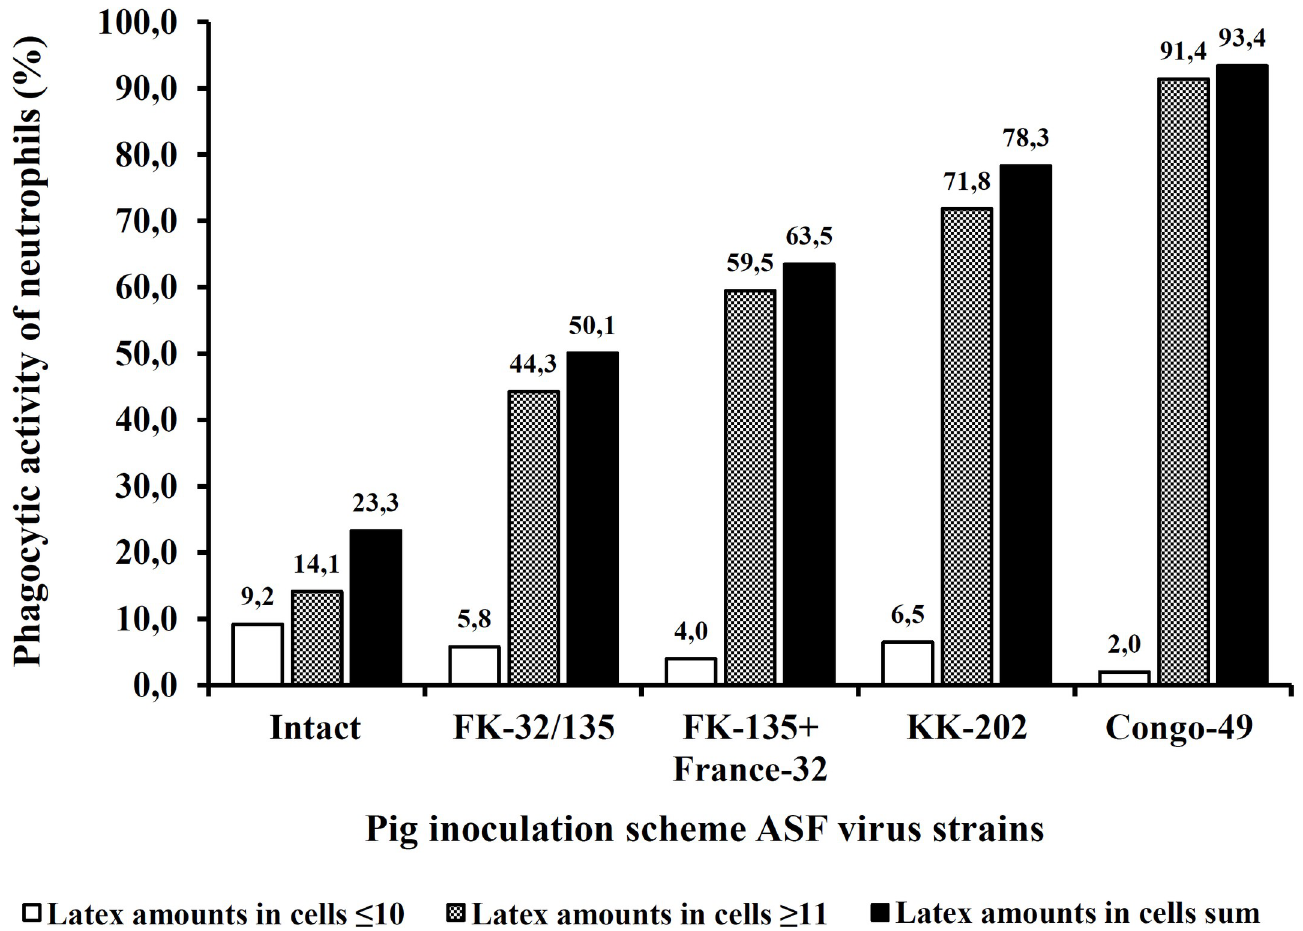
Fig 2. The effect of pig inoculation with attenuated, vaccine and virulent ASFV strains on the mean phagocytic activity of porcine blood neutrophils (blood samples were collected four days after inoculation), n = 4.